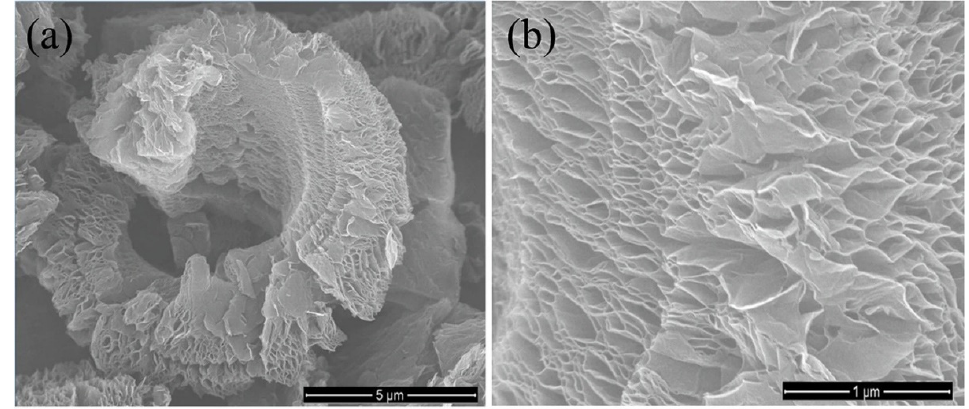
Figure 10. SEM images of reduced graphene oxide (rGO). SEM images at ( a ) low and ( b ) high magnification [162] (CC BY).